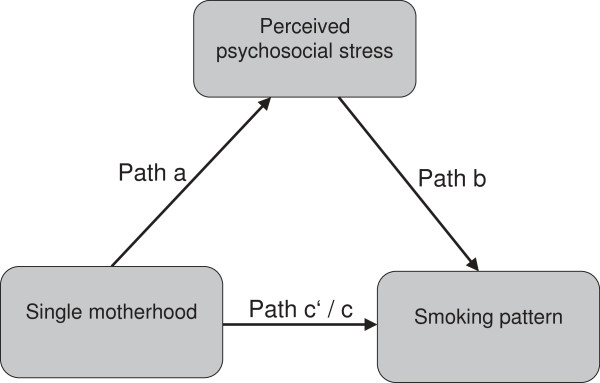
The Mediator Model of single motherhood on moderate and heavy smoking patterns. Path c indicates the total, c’ the direct and path a * b the indirect effect of X on Y.